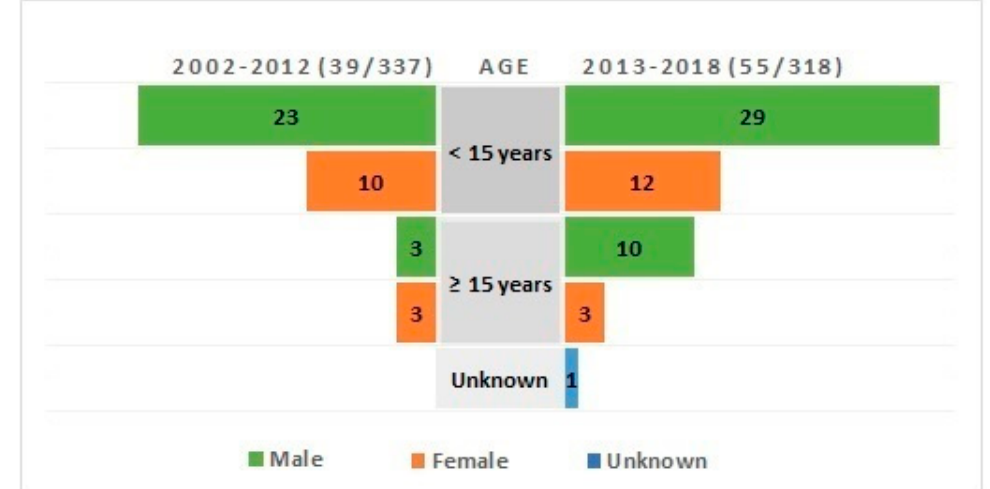
Figure 3. Demographic of individuals with confirmed enterovirus encephalitis in 2002–2012, and in 2013–2018.